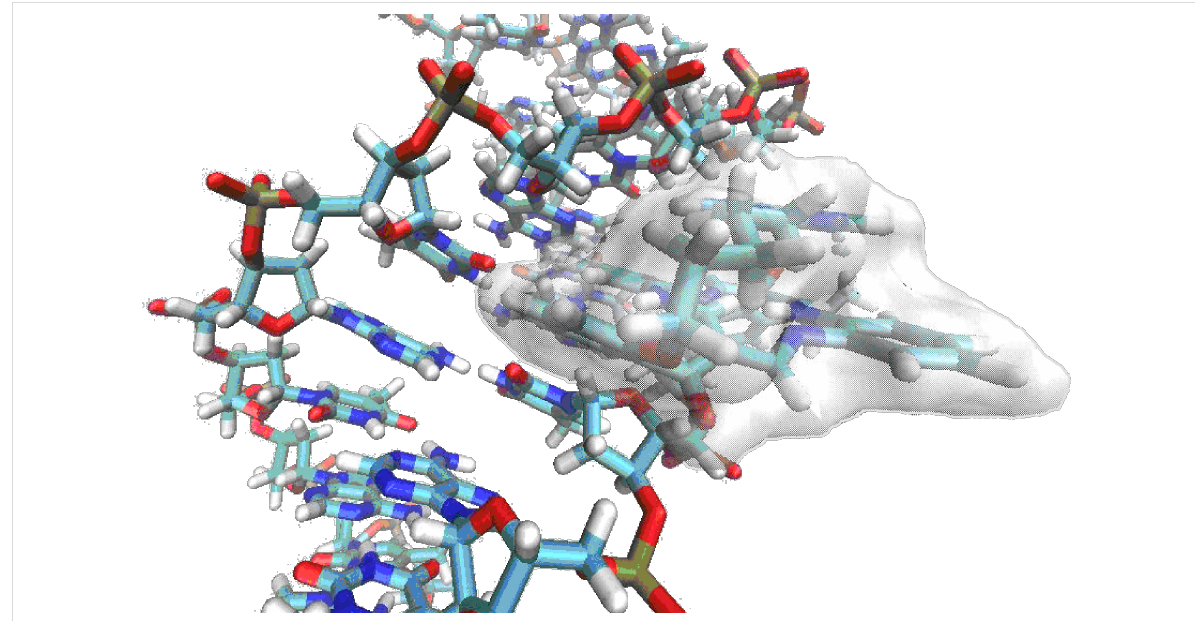
Figure 5: Schematic presentation of self-folded AP5 (free AP5 see Figure 4; upper left) in the minor groove of poly dAdT–poly dAdT. Double stranded DNA (previously used in [6]) was created with the program NUCGEN, a part of the AMBER11 program suite [21]. The self-folded ligand AP5 was docked manually into the poly (dA–dT) 2 polynucleotide minor groove by using the program VMD [22], taking into account that VdW radii of DNA and ligand do not overlap.